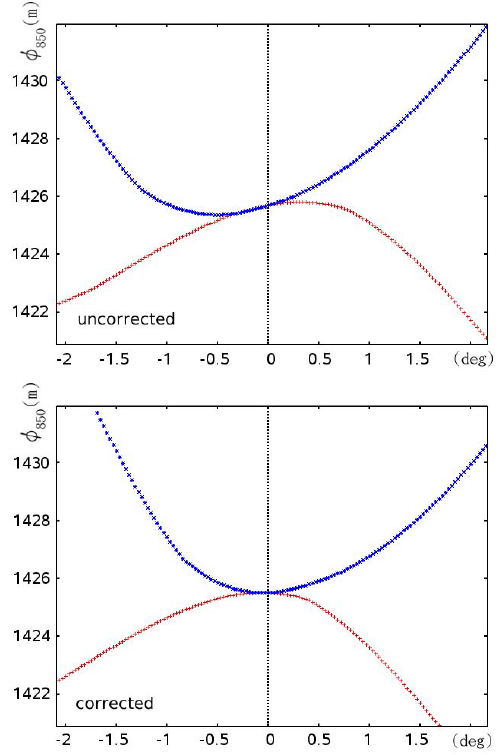
Fig. 3. The two panels show φ 850 as a function of the distance (de- grees) away from AC and along the directions of maximum growth (blue) and diminish (red) before (top) and after (bottom) the correc- tion using φ 850 is